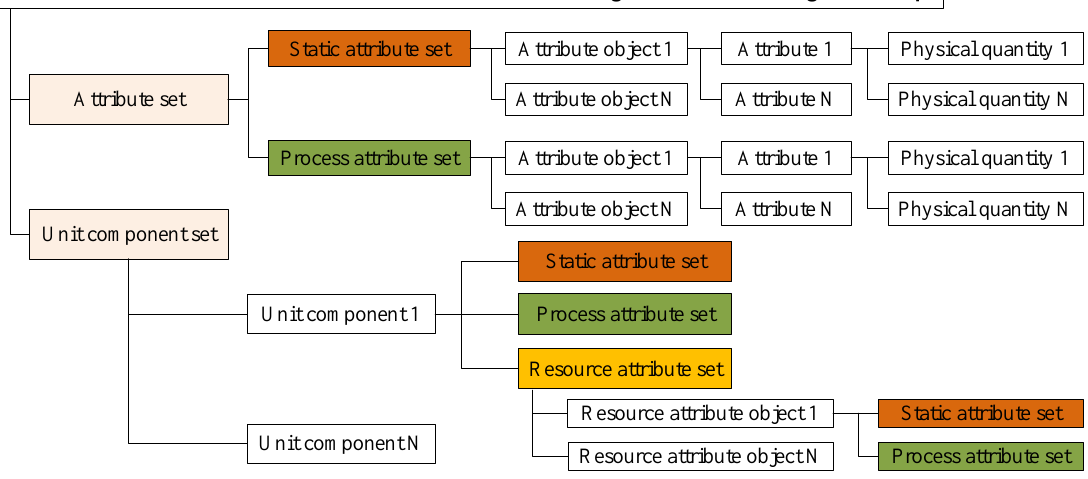
Figure 4. Hierarchical architecture of intelligent manufacturing workshop information model.